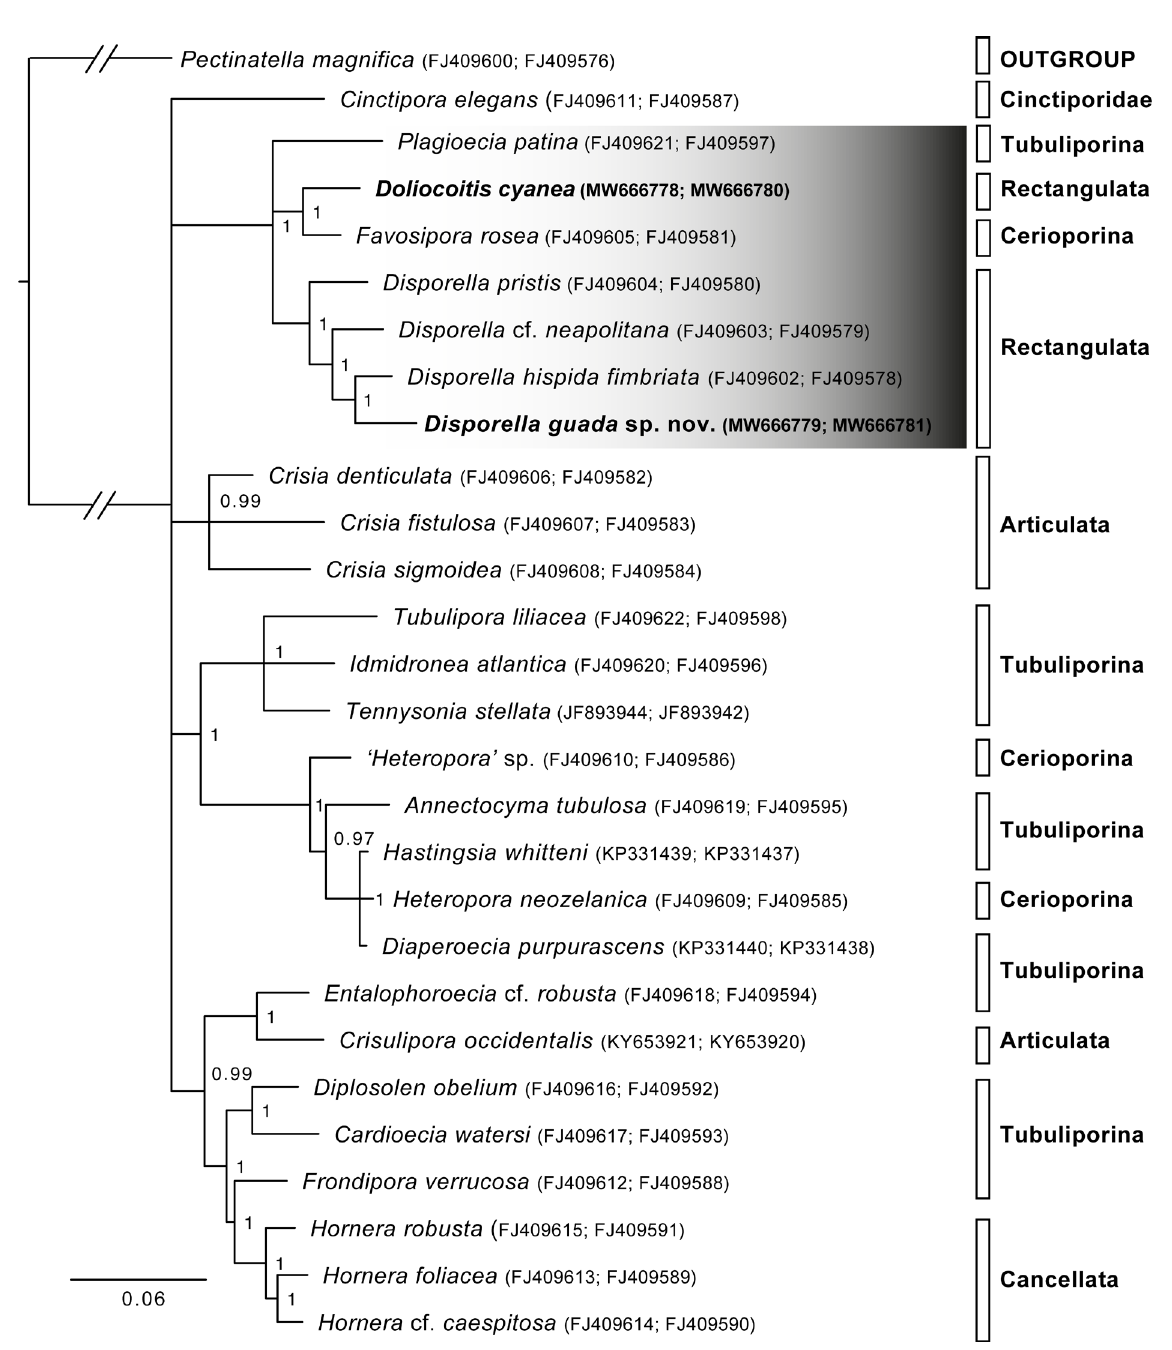
Fig. 6. Bayesian analysis of the concatenated 18S + 28S rDNA dataset constructed using MrBayes ver. 3.6.2 under the GTR + I + G model of nucleotide evolution. The analysis was run for 10 million generations; 7 million generations were discarded as burn-in. Posterior probabilities are given at the nodes. All nodes with < 0.95 posterior probabilities have been collapsed. The branch length scale bar indicates number of substitutions per site. Higher level classification is given at the right-hand side. Emboldened terminals indicate newly generated